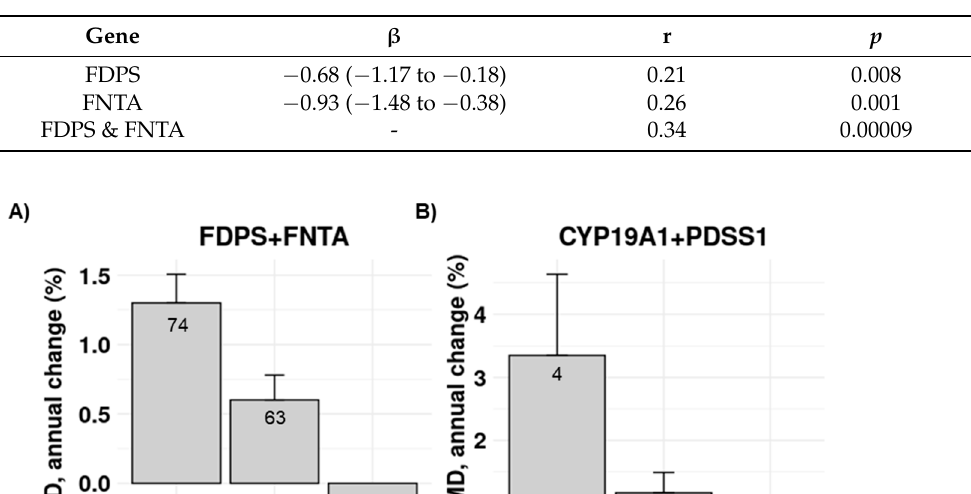
Table 6. Association of genes of the mevalonate pathway with the BP-induced changes in hip BMD; results of the linear regression of the most significant SNP in each gene; Both the univariate and multivariate analyses are shown.